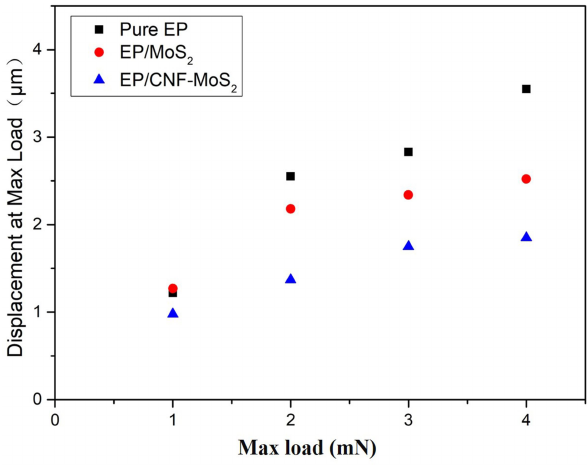
Table 1: Average E and H of coating specimens at an